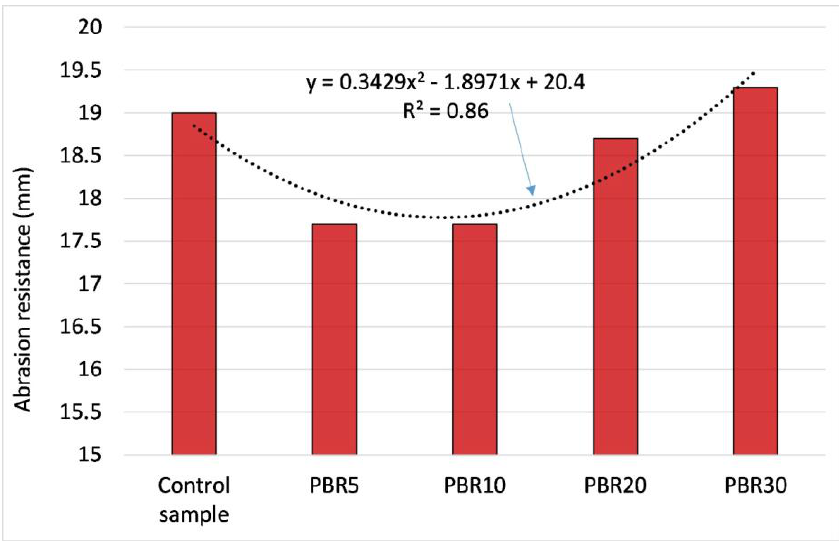
Figure 8. Abrasion resistance of CR IPB at 28